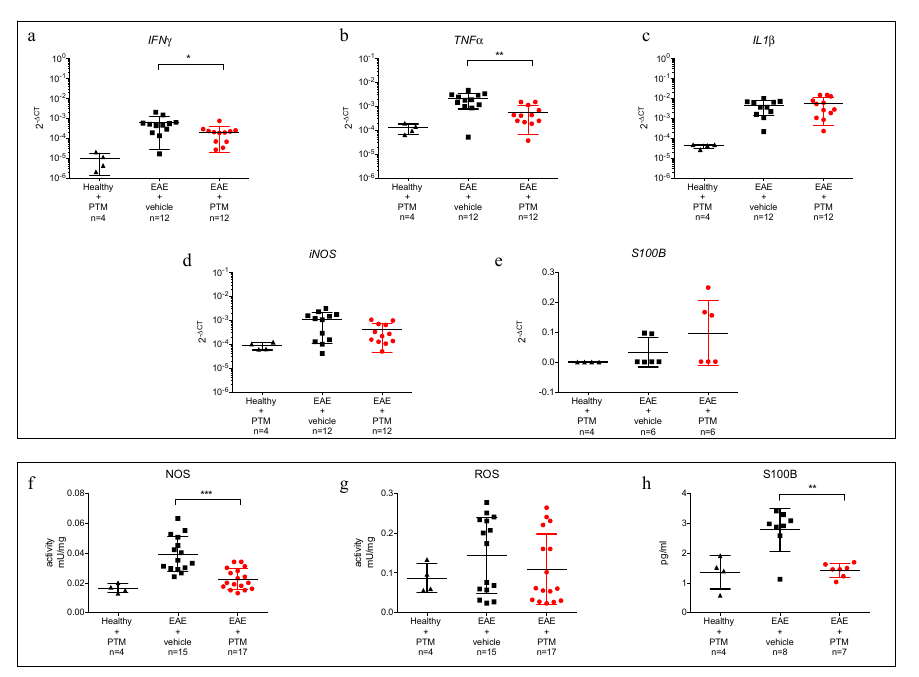
Figure 2. Impact of pentamidine (PTM) on gene expression and protein levels of inflammatory cytokines, S100B, nitric oxide synthase (NOS), and radical oxygen species (ROS) during EAE. ( a – c ) qPCR, performed on total mRNA extracted from the emi-brain of treated (PTM), untreated (vehicle) EAE, and CTRL (PTM treated healthy mice), shows a significant reduction in PTM-treated animals for the expression of IFN γ (a, p = 0.03) and TNF α (b, p = 0.008), despite no difference of IL1 β ( c ). No change of inducible nitric oxide synthase iNOS and S100B mRNA is observed ( d , e ). Colorimetric activity assay for NOS shows a significant difference ( f, vehicle vs. PTM p < 0.0001), while ROS activity does not reveal any change during PTM treatment ( g ). S100B has been measured by ELISA (h) resulting in a significant downregulation of the S100B protein ( p = 0.0085). Statistical analysis has been performed using Mann–Whitney test. The qPCR analyses for cytokines and iNOS ( a – d ) have been performed on a total of 28 mice (12 EAE–PTM-treated, 12 EAE-vehicle-treated and 4 healthy-untreated), excluding EAE affected mice sacrificed during remission phase. The qPCR and the ELISA for S100B ( e , h ) were performed on mice of the second experiment (because the samples of first experiment were not usable in terms of quality and quantity) on a total of 19 mice (7 EAE–PTM-treated, 8 EAE–vehicle-treated and 4 healthy untreated); for S100B qPCR three results were missing (1 in EAE–PTM-treated and 2 EAE–vehicle-treated groups). Colorimetric activity assays for NOS and ROS ( f , g ) have been performed on 36 mice (17 EAE–PTM treated, 15 EAE–vehicle treated and 4 healthy untreated). For graphical reasons, y -axes are displayed in logarithmic for cytokines and iNOs mRNA expression ( a – d ) and linear y -axes for S100B mRNA expression ( e ) and colorimetric and ELISA assays ( f – h ). * p < 0.05; ** p < 0.001; *** p < 0.0001.